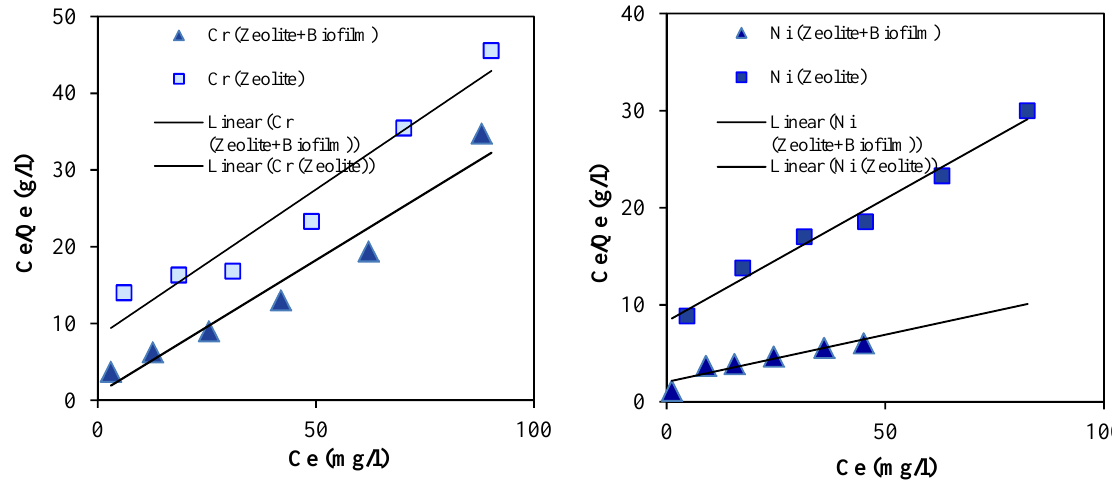
Figure 3. Biosorption isotherms of nickel and chromium based on the Langmuir model